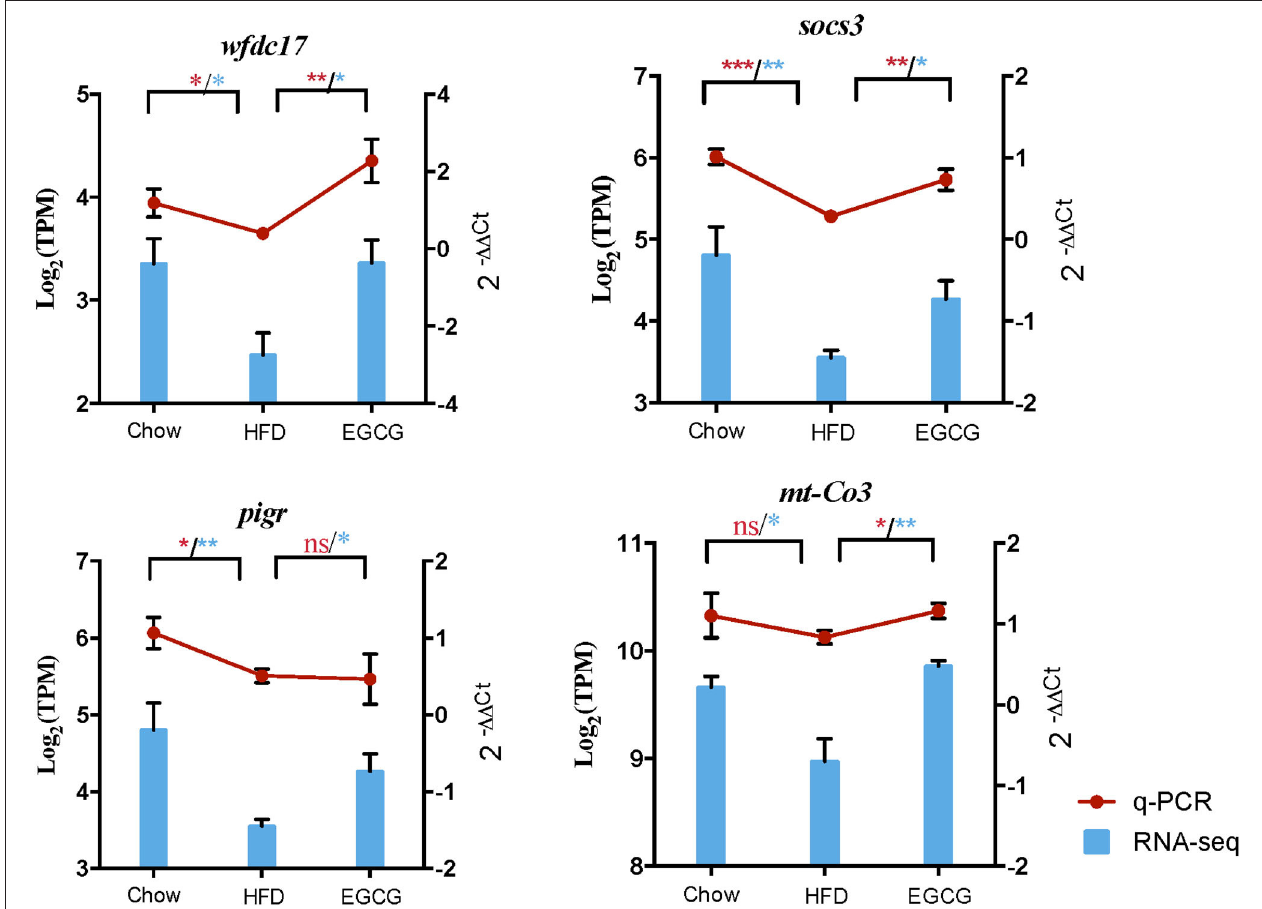
FIGURE 8 | Quantification of the expressed genes using RT-qPCR. The RT-qPCR results were shown by red line chart, and RNA-seq results were shown by blue column chart. Statistically significant difference of RT-qPCR and RNA-seq was both analyzed by t -test, which was represented with red and blue asterisk, respectively. * p < 0.05, ** p < 0.01, *** p <